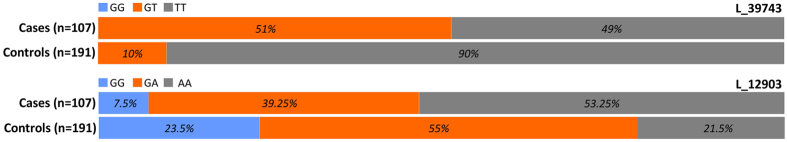
Genotype frequencies of the two best associated SNPs L_39743 and L_12903.